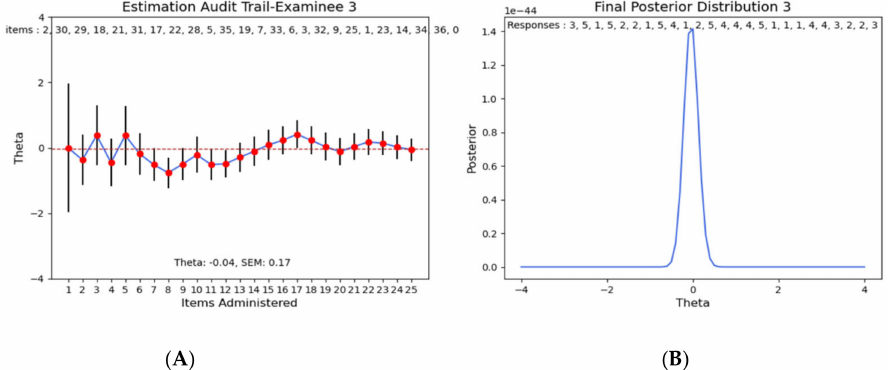
Figure 6. An example of an examinee’s estimated ability change using CAFT. ( A ) The examinee took 10 items and his estimated ability changed in terms of the adaptively selected items. ( B ) The final estimated ability of the examinee.